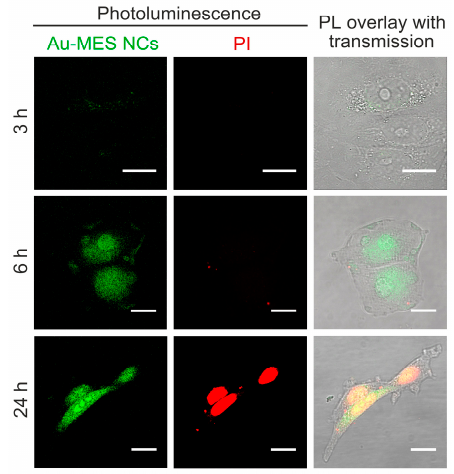
Figure 4. Accumulation of photoluminescent Au-MES NCs ( λ ex = 405 nm) in MCF-7 breast cancer cells after 3, 6, and 24 h of incubation (green photoluminescence). Red fluorescence represents propidium iodide (PI) stained non-viable cells ( λ ex = 488 nm). Yellow color in the merged pictures presents overlap of photoluminescence of Au-MES NCs and fluorescence of propidium iodide. Scale bar is 15 µ m.